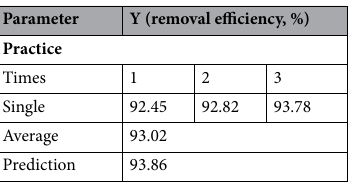
Table 8. Optimum value of the process parameter for maximum